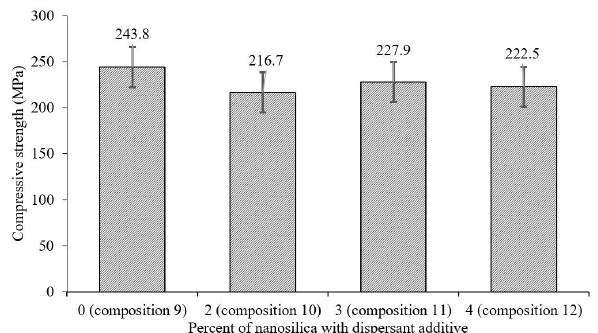
Figure 5. Influence of nanosilica content in powder reactive concrete compressive strength – Phase 2.